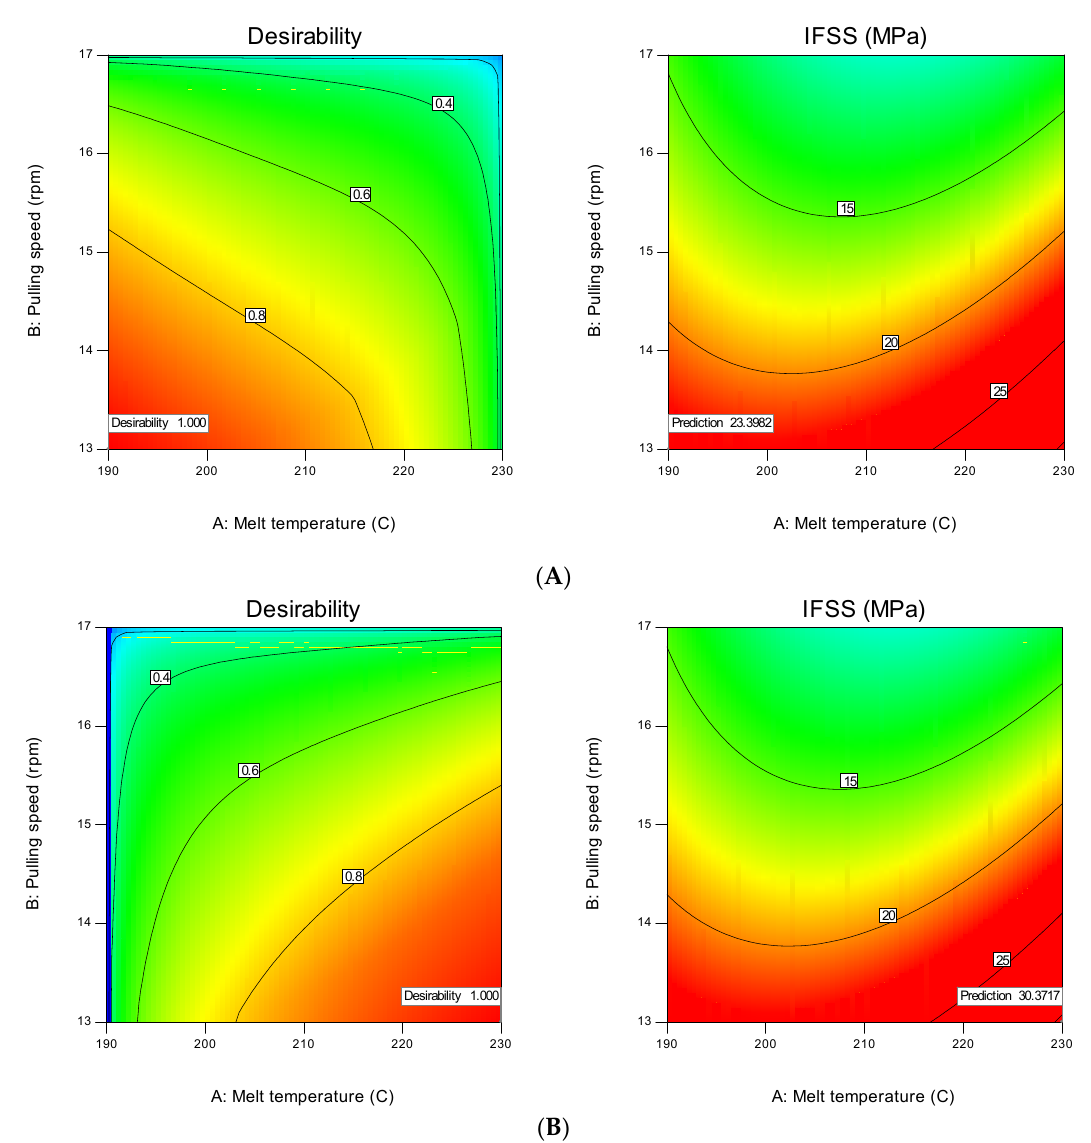
Figure 16. Optimisation solution at ( A ) the minimum melt temperature and ( B ) the maximum melt temperature.